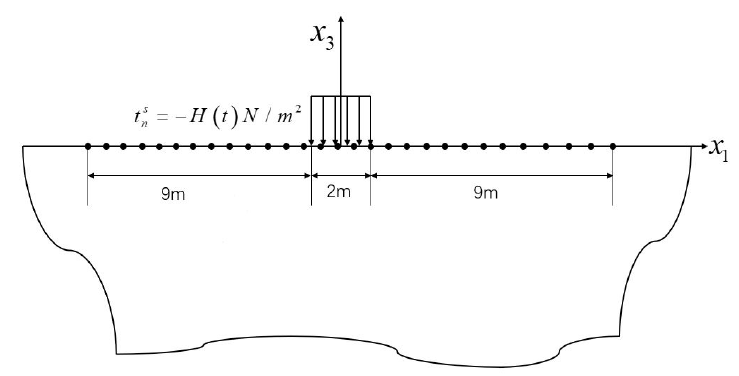
Figure 6. The sketch of the semi-infinite domain.